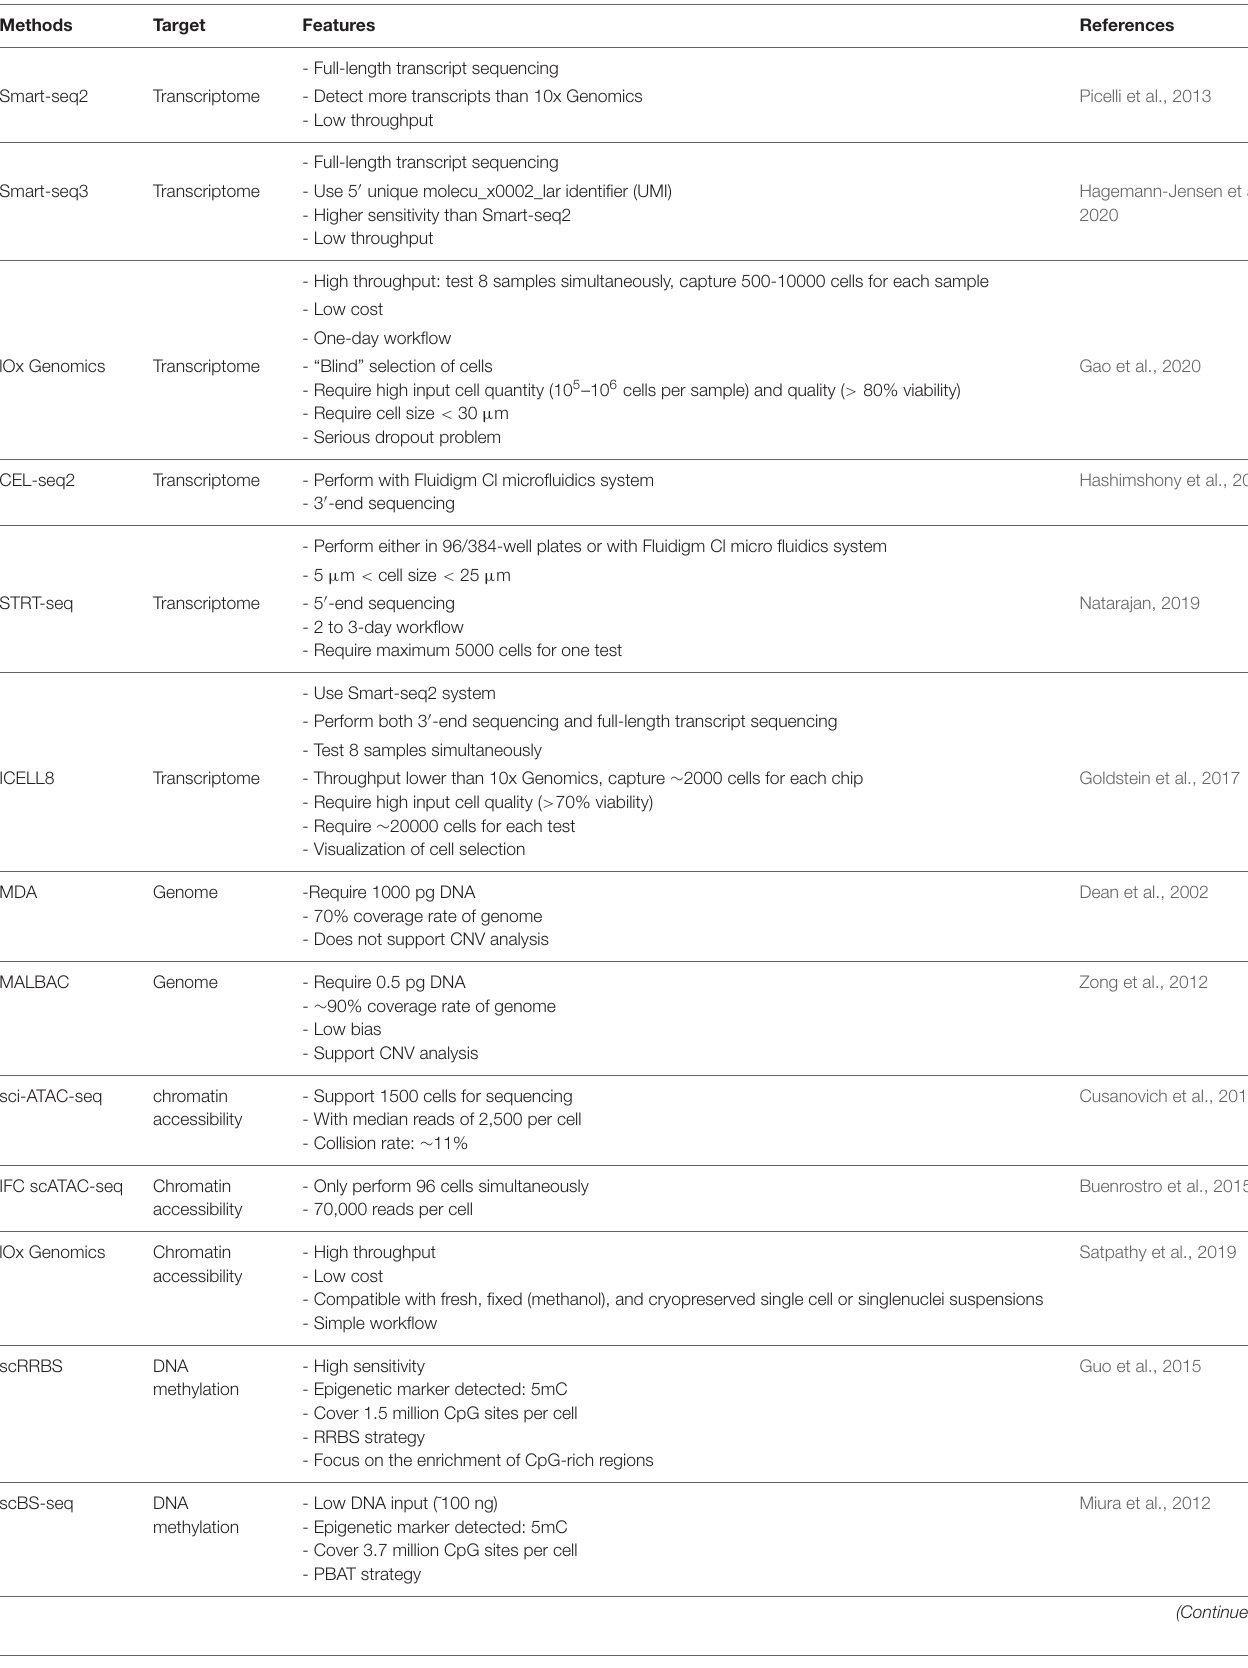
TABLE 1 | Main features of the single-cell